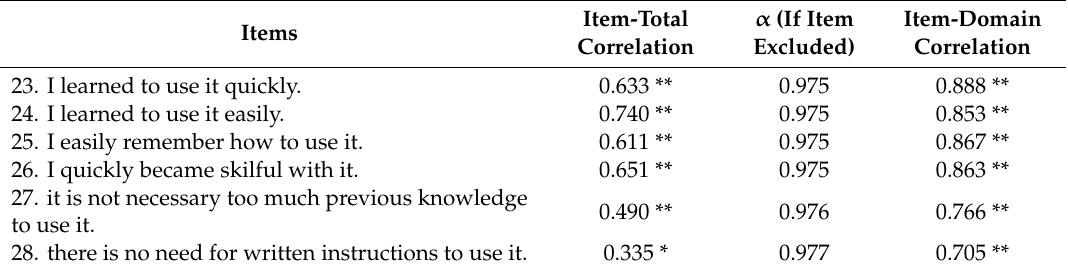
Table 4. Ease of learning items (Concerning the double-chamber syringe for intravenous therapeutics).